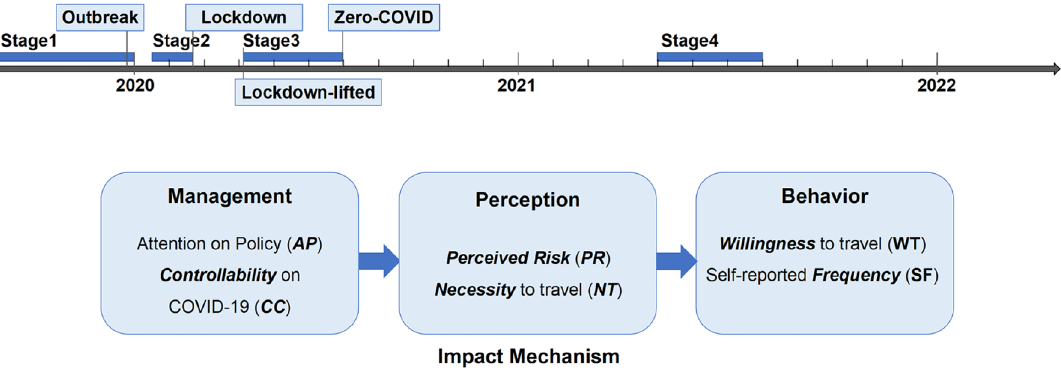
Figure 1. Graphic abstract of the design of the study.